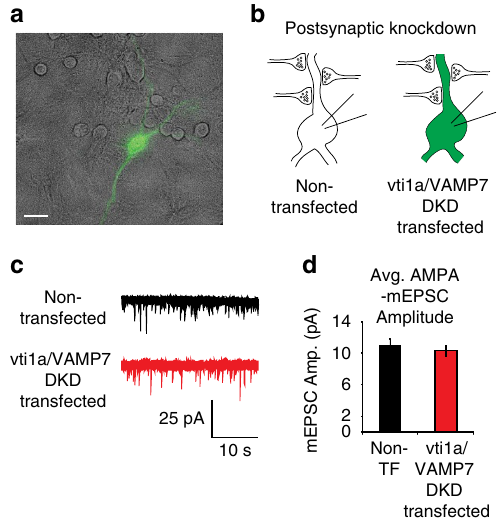
Figure 5 | Postsynaptic loss of vti1a and VAMP7 is insufficient to elicit synaptic scaling of excitatory unitary event amplitudes. ( a ) Representative image of a GFP-positive neuron expressing shRNA constructs against vti1a and VAMP7 overlaid by a brightfield image showing many neighbouring GFP-negative (non-transfected control) neurons. Scale bar, 30 m m. ( b ) Diagram of experimental design to test the potential postsynaptic effects of vti1a/VAMP7 DKD in rat hippocampal cultures. AMPA-mEPSC recordings were made from both GFP-negative, control neurons and GFP-positive, vti1a/VAMP7 DKD-transfected neurons that receive predominantly control presynaptic inputs due to very low transfection efficiency. ( c ) Representative AMPA-mEPSC recordings from non-transfected (control) and vti1a/VAMP7 DKD-transfected neurons. vti1a/VAMP7 DKD-transfected postsynaptic neurons